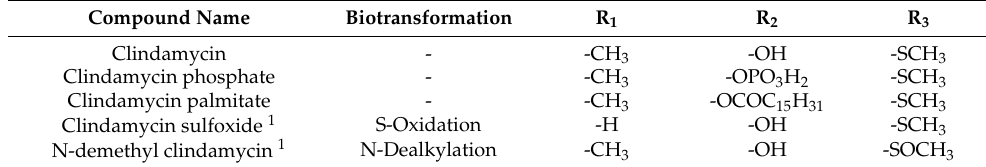
Table 1. Structural information for clindamycin and related components.